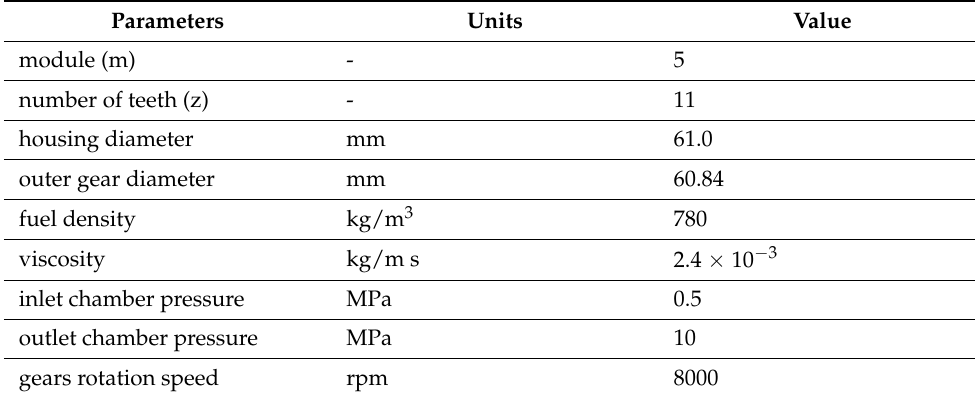
Table 2. Simulation model parameters for the fuel system.